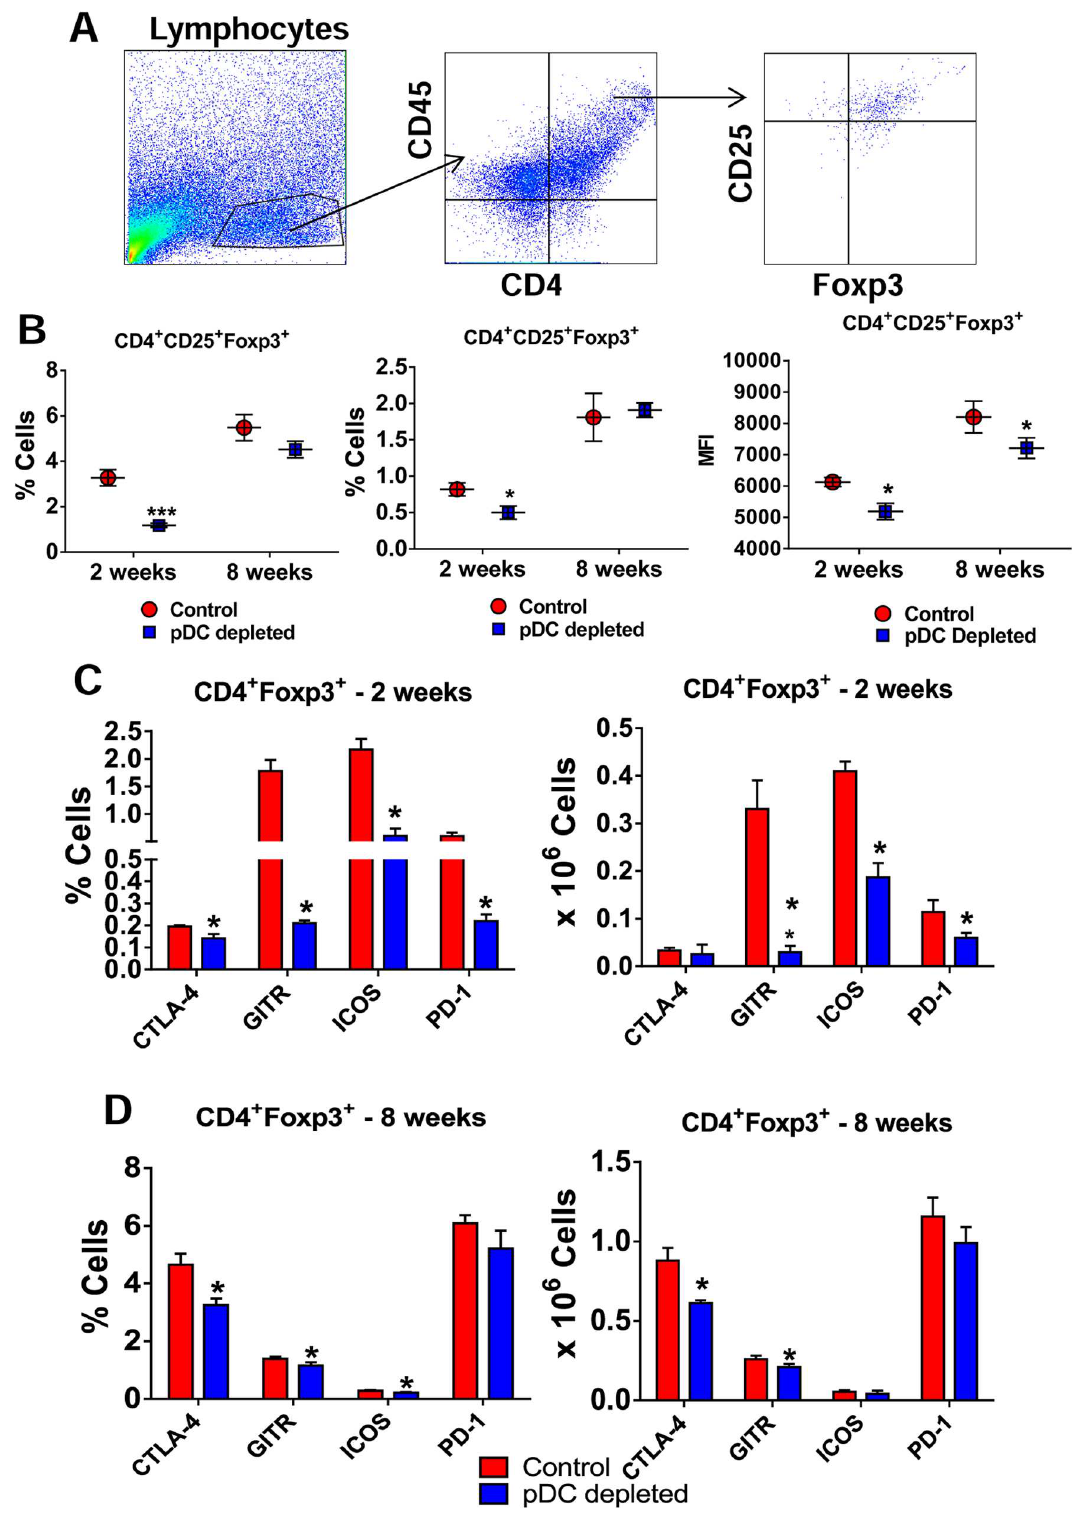
Fig 8. Depletion of pDCs impairs the influx of Treg cells to the lung of P . brasiliensis infected mice. (A) Representative FACS plots demonstrating the gating strategy for CD4 + T and Treg cells. (B) Frequency (left panel), absolute numbers (central panel)and medianfluorescence intensity (MFI, right panel)of CD4 + Foxp3 + T cells